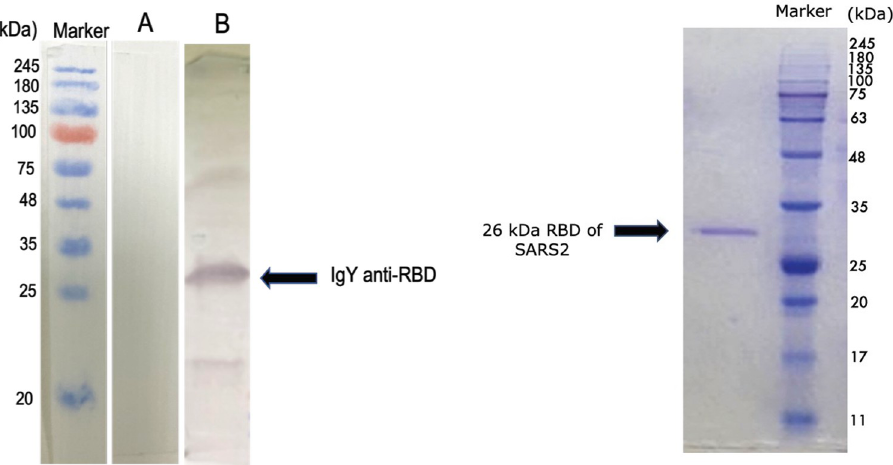
Fig 3. Analyses using western blotting and SDS-PAGE under reducing conditions. Left side is a representative western blot showing IgY from adjuvant-only immunized eggs (Lane A) and from eggs that were immunized with SARS-CoV-2 RBD. The anti-RBD IgY antibody specifically binds to the RBD protein (Lane B). Right side shows the SDS-PAGE of recombinant RBD (Lane C) (molecular weight 26 kDa).